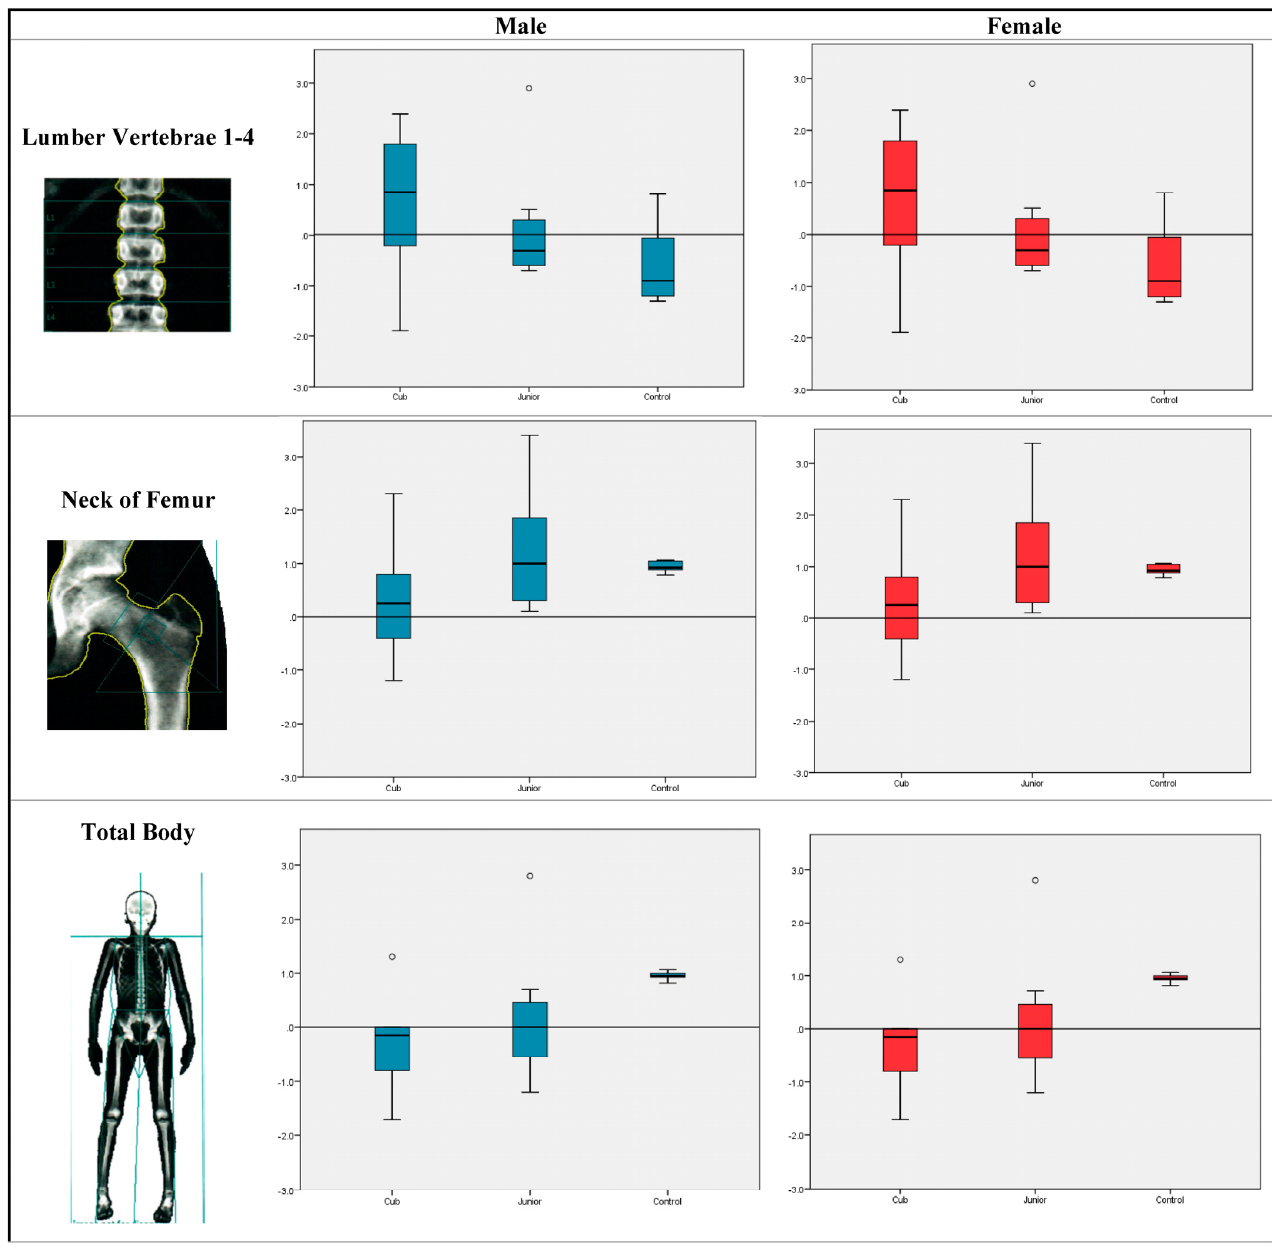
Figure 2. Mineral density Z-score distribution in lumber 1–4, femoral neck, and total body among cadets, juniors, and non-athletic controls.